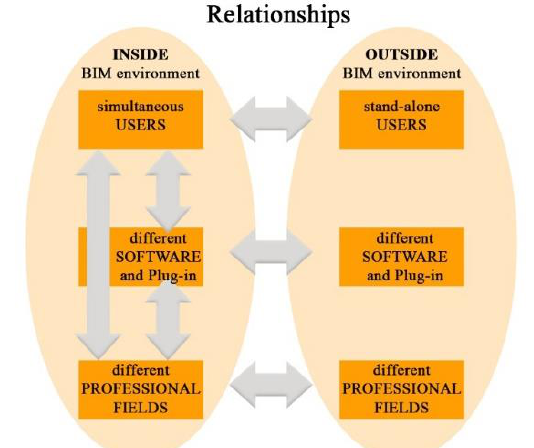
Figure 2. The relationship’s structure of the interoperability’s bonds.